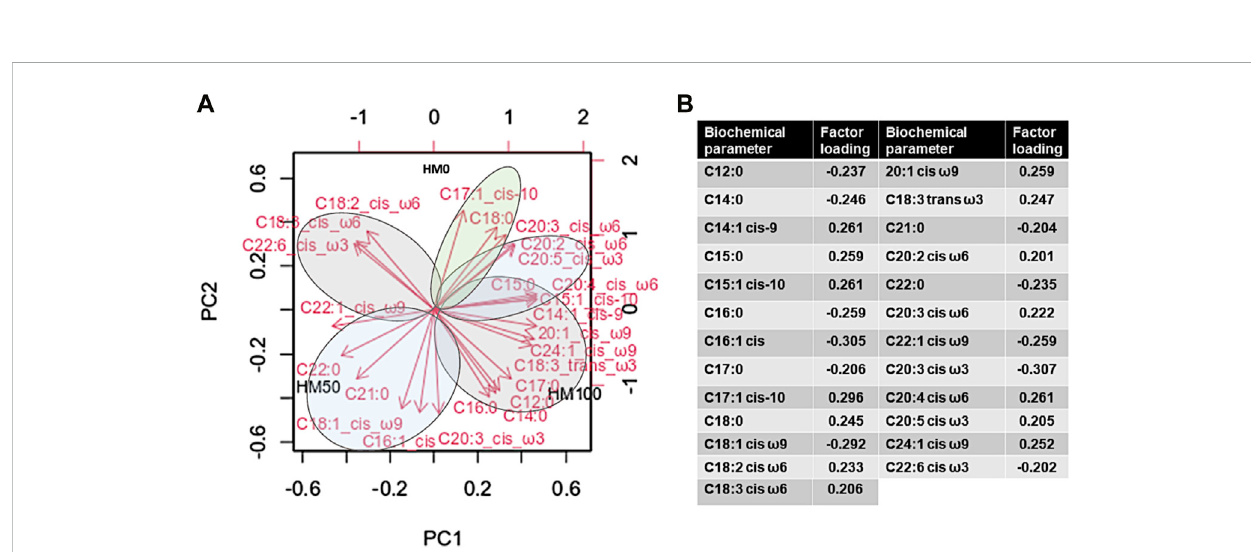
FIGURE 7 (A) Variablecorrelationswitheachofthe fi rsttwoprincipalcomponents(PCs)inthemultivariateanalysis.ThePCAwasgeneratedfromthecomplete fatty acids dataset. Parameters with redvector arrows were included as predictors in constructingthePCA. (B) Analyticaltable ofthecontribution offatty acids according to factor loadings. HM0 represents the control group whileHM50 and HM100 thegroups with 50% and 100% HM inclusion